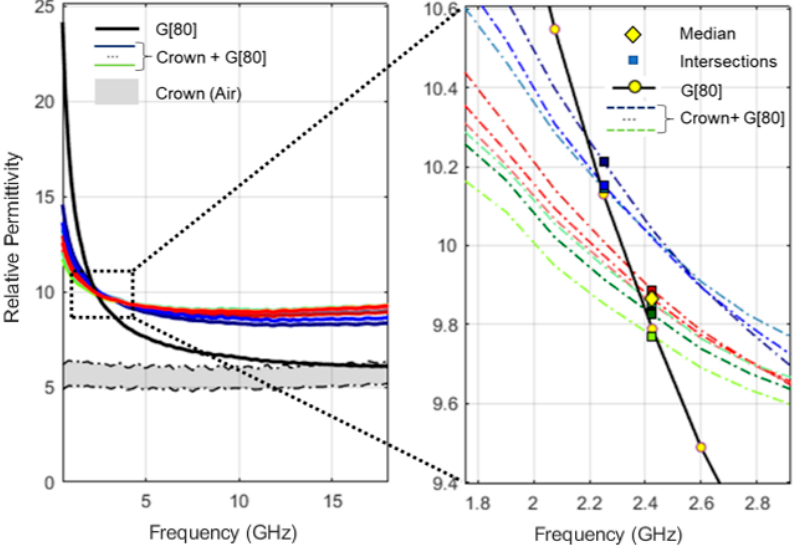
Figure 5. Example of the estimation of the premolar crown relative permittivity with application of coupling medium G[80]. The solid ( left ) and dashed ( right ) lines show the relative permittivity recorded with the application of G[80] over the crown. Relative permittivity of G[80] is represented by a solid black line. The zoomed in region shows intersections (squares) observed for each acquisition. The median value (yellow diamond) of the relative permittivity observed at the intersection points was selected as the estimation of the relative permittivity of the crown. The intersections were determined for the sampled frequencies (yellow circles); thus, there is a slight deviation between the intersections obtained and the points where the interpolated curves intersect. Crown relative permittivity measured without the application of the coupling medium (air) is represented, for reference, by a shaded band.